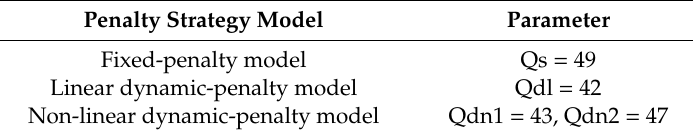
Table 5. Optimized penalty factor parameters.